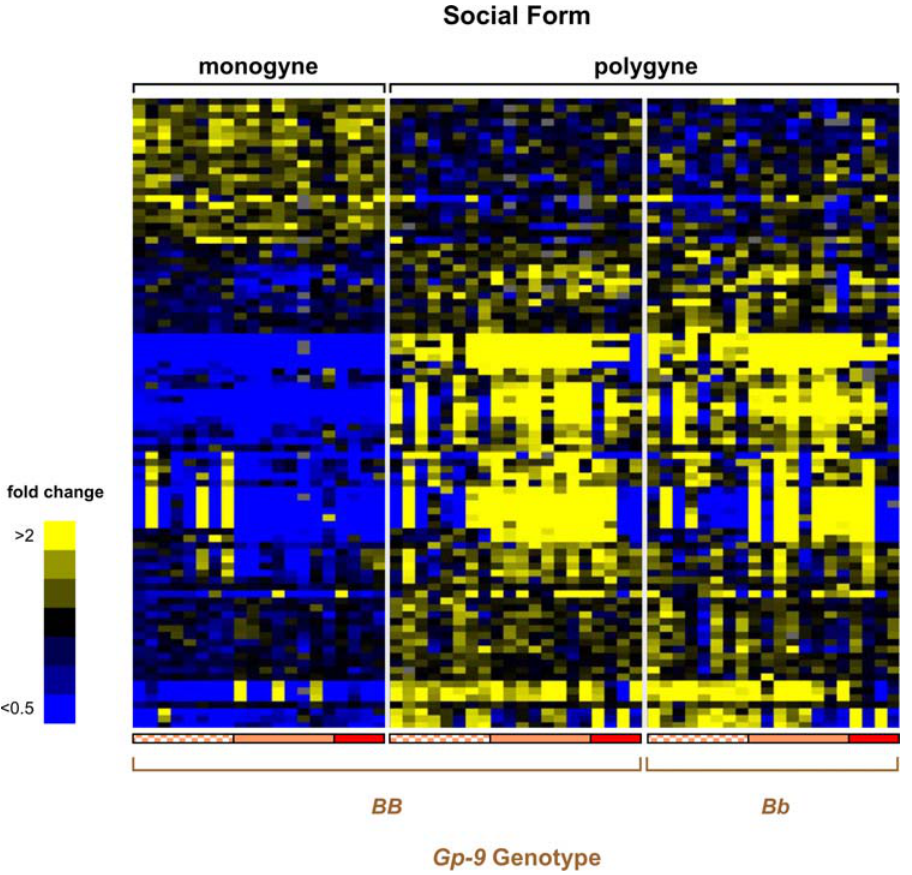
Figure 2. Expression profiles between S.invicta adult workers from monogyne and polygyne colonies. Expression profiles for 91 differentially expressed genes are depicted (ANOVA, 10% FDR). Rows and columns represent data as described in the Figure 1 caption. See Text S1 and Table S1 for confirmation of selected gene expression results with qRT-PCR.